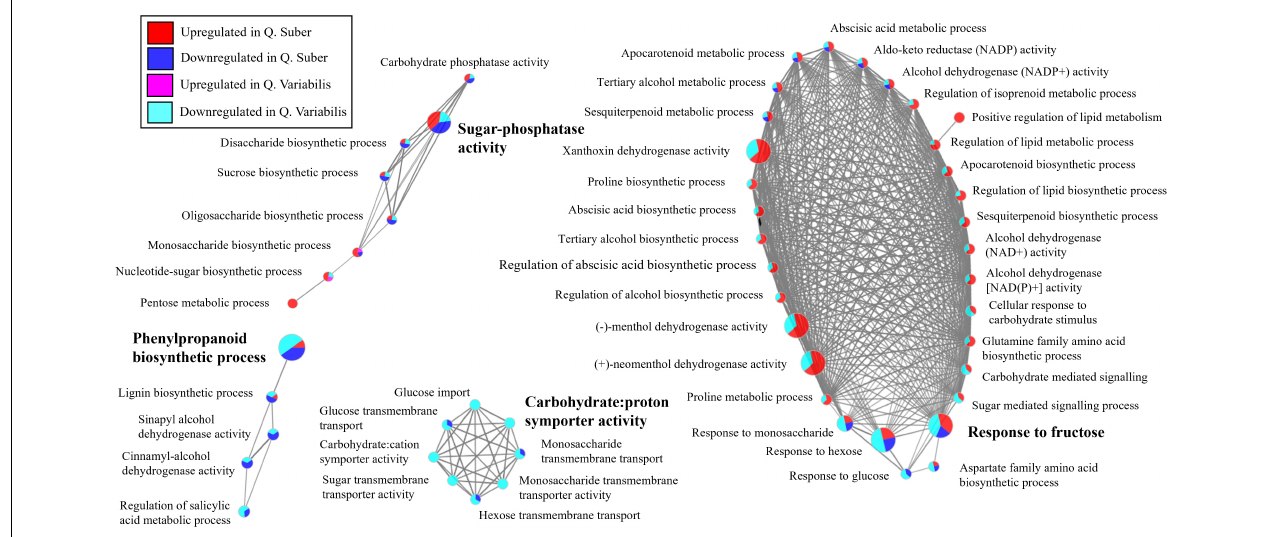
FIGURE 8 | Functionally annotated biological process network constructed by ClueGO at kappa score ≥ 0.4 for root proteins affected in Q. suber and Q. variabilis 36 h after inoculation with P. cinnamomi .